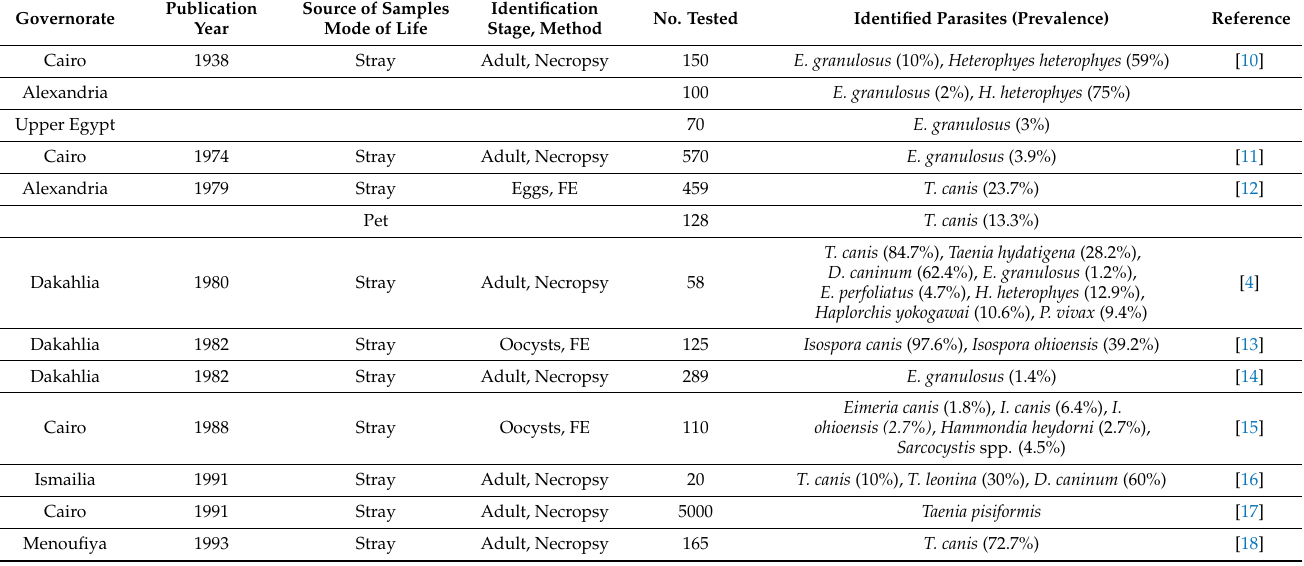
Table 2. Characteristics of studies included in various meta-analyses conducted in the present study. Abbreviation: FE, fecal examination; NS, not